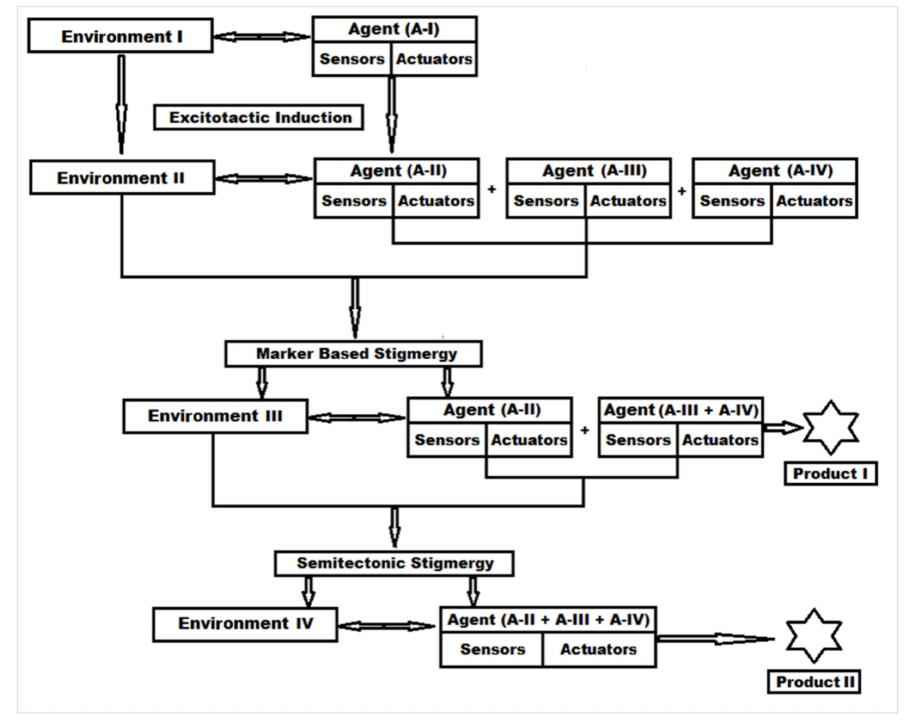
Figure 1. Schematic representation of peptide biomaterial synthesis by environment-reliant auto-programmer